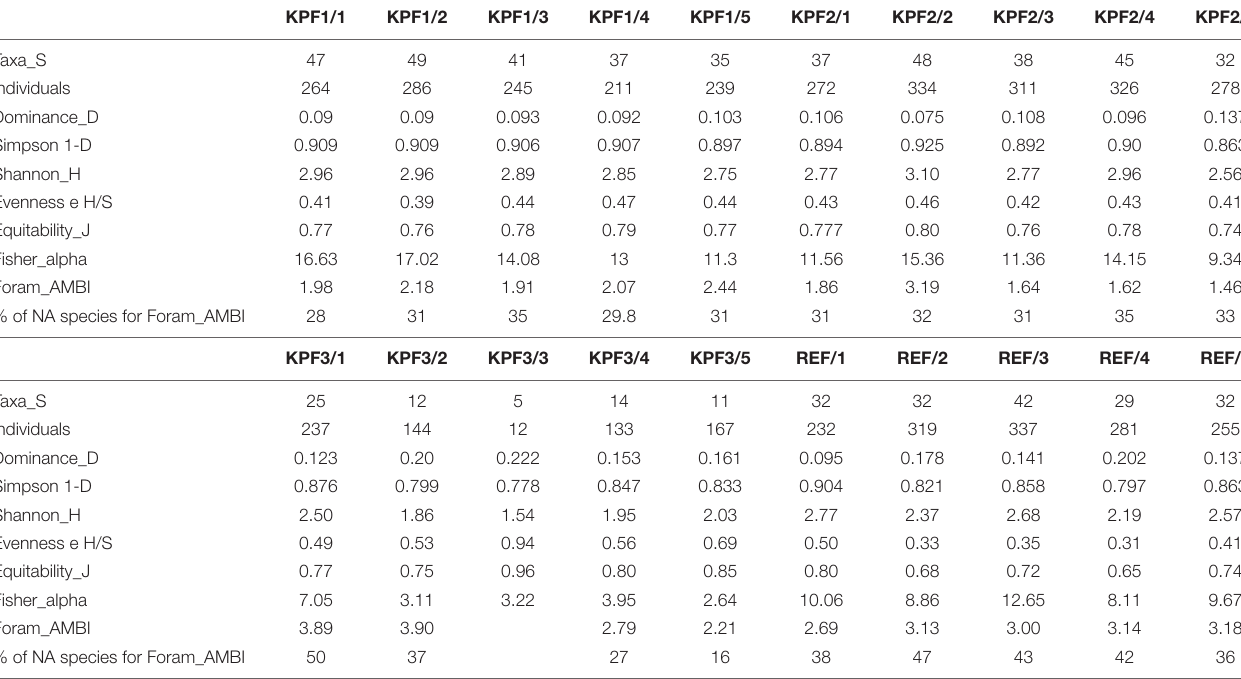
TABLE 3 | Number of taxa (Species richness), number of individuals, diversity indices from standardized aliquots for total assemblages from four locations (KPF1, KPF2, KPF3 and REF) from the Bay of Koper.